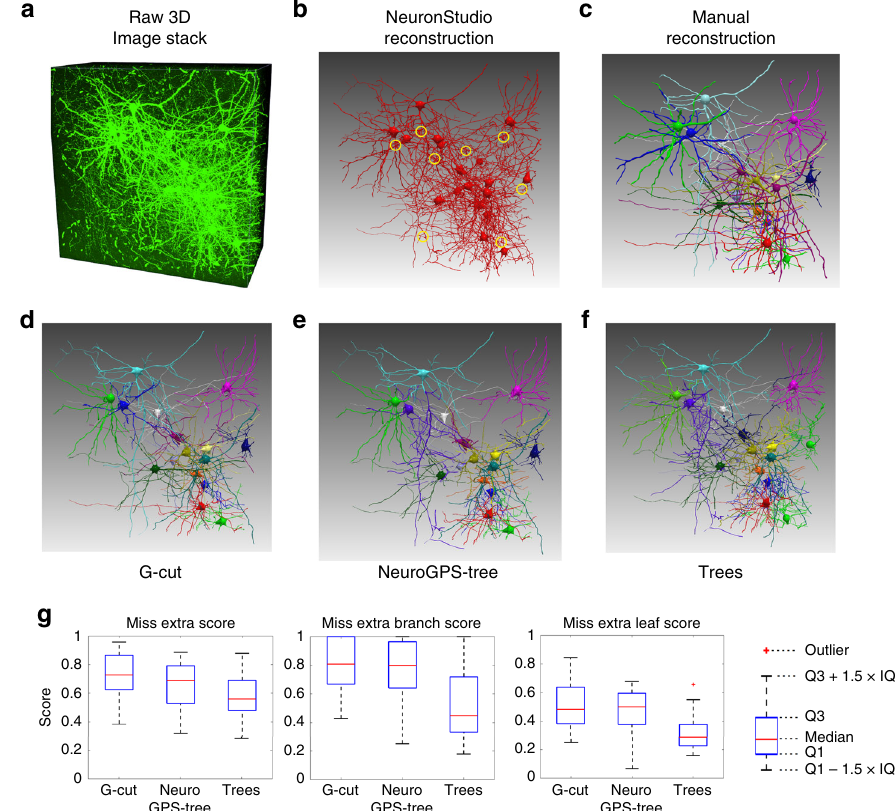
Fig. 6 Performance of G-Cut, NeuroGPS-tree and TREES toolbox on densely connected neurons. a The raw image stack. Data size: 1024× 1024 × 500 voxels. b A neuron cluster was automatically reconstructed from the image stack by NeuronStudio software. The neuron cluster contained 108 spurious links in total. Some representative spurious links were marked in yellow circles. c Sixteen neurons were manually reconstructed from the raw image stack with neuTube software and used as ground truth. d – f The neuron cluster in b was segmented into individual neurons by G-Cut, NeuroGPS-tree and TREES toolbox, respectively. Identical post-processing was used on segmentation results from all three algorithms (see Supplementary Fig. 7 and Supplementary Note 2). g Miss-Extra-Scores of the sixteen neurons reconstructed by G-Cut, NeuroGPS-Tree and TREES toolbox. The MES was obtained by comparing an automatic reconstruction result with the manual reconstruction result of each neuron. The red line represents median MES. Source data are provided as